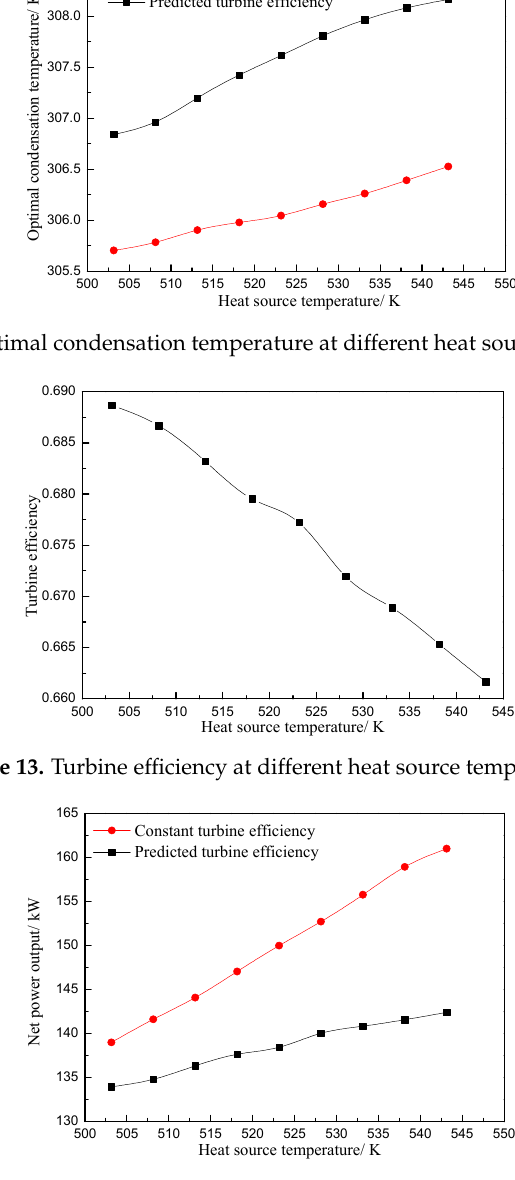
Figure 14. Net power output at different heat source temperature.